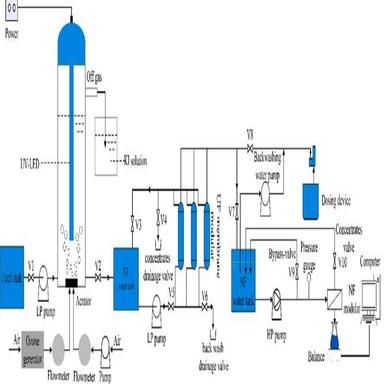
Schematic diagram of the experiment setup.